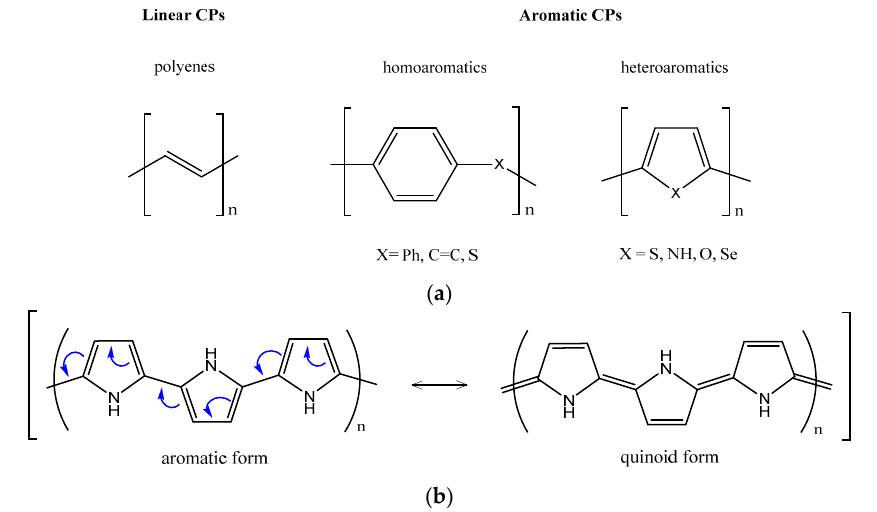
Figure 2. ( a ) Basic classification of conjugated polymers (CPs); ( b ) Mesomeric limiting aromatic and quinoid forms—case of PPy.